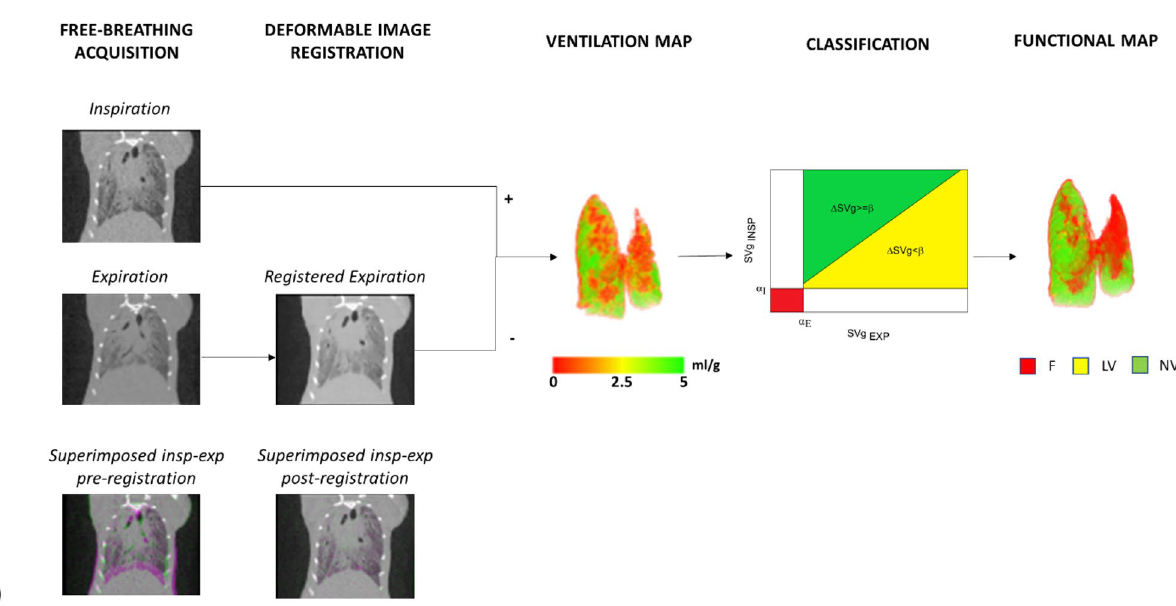
Figure 1. ( A ) The image processing algorithm. The images are acquired in free-breathing and reconstructed at peak inspiratory and peak expiratory states. Deformable image registration is applied to match corresponding voxels in the expiratory and the inspiratory images. After converting the images in specific gas volume, the ventilation map is obtained by subtracting the deformed expiratory from the inspiratory image. Based on DSVg and inspiratory and expiratory SVg values, each voxel of the lung is classified as fibrosis (red), low ventilation (yellow) and normal ventilation (green). ( B ) Superimposed inspiratory and expiratory images before and after registration, with non-matched regions pre-registration (right) coloured in pink(near the